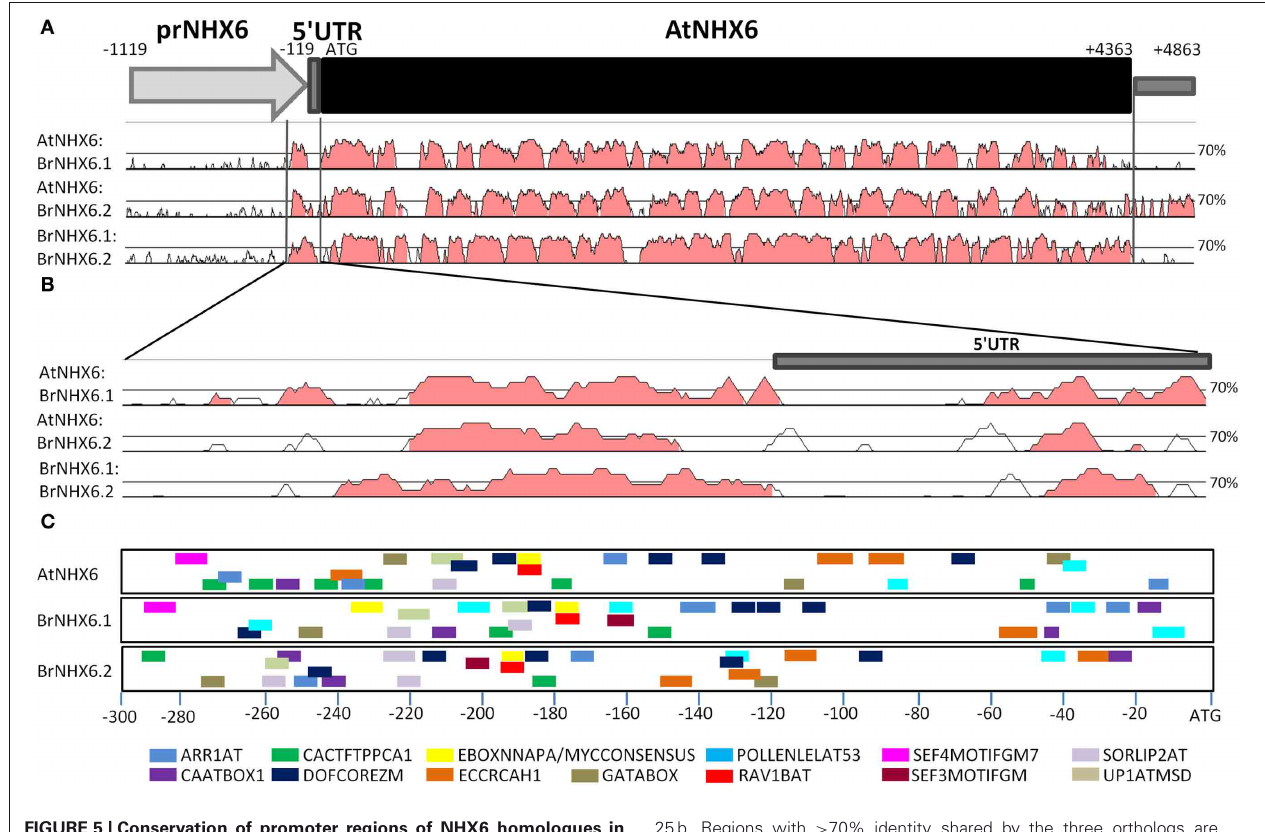
FIGURE 5 | Conservation of promoter regions of NHX6 homologues in B. rapa . Graphic output for comparisons of Arabidopsis and B. rapa IC II NHX genome region (A) and putative promoter region (B) using VISTA, with parameters of at least 70% identity within a window of